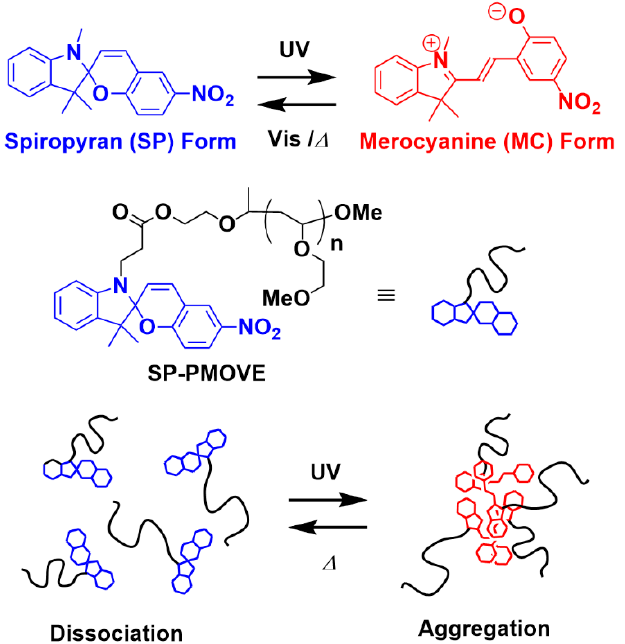
Figure 1. Schematic representation of the formation and deformation of aggregates of SP-PMOVE in EtOH upon photoirradiation.